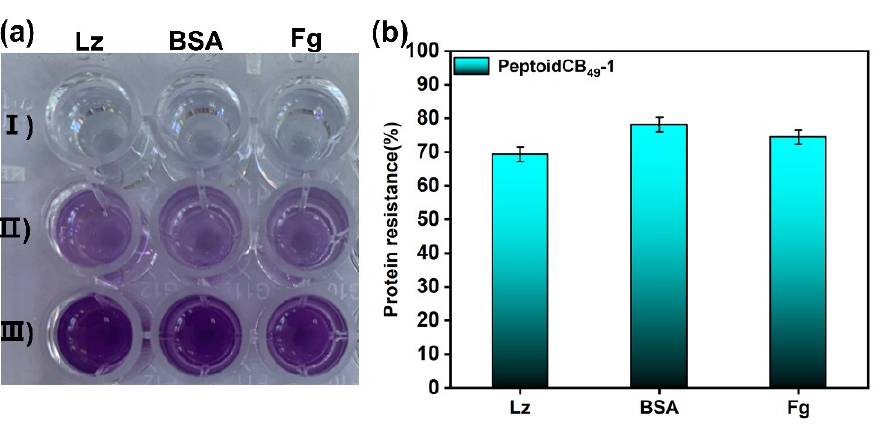
Figure 4. ( a ) Micro-BCA reagent (blank, I) chelated with the proteins from PeptoidCB 49 -1 hydrogel surface (II) and bare agarose hydrogel surface (III), ( b ) the resistance of different proteins (Lysozyme, BSA, and Fg) on the hydrogel surface (the error bars represent the standard deviation, n =